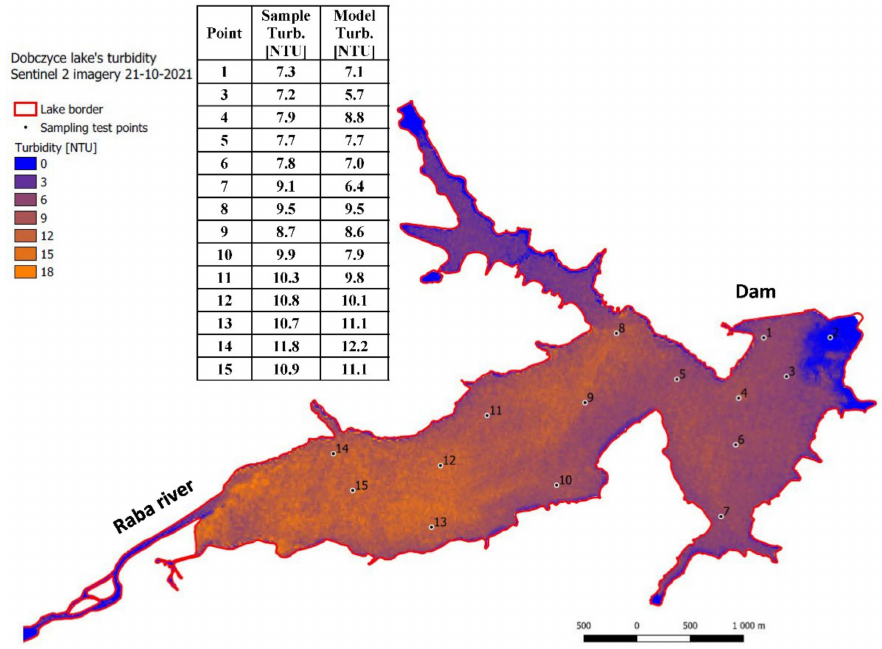
Figure 21. Water turbidity of Lake Dobczyce, 21 October 2021 (imagery by Sentinel